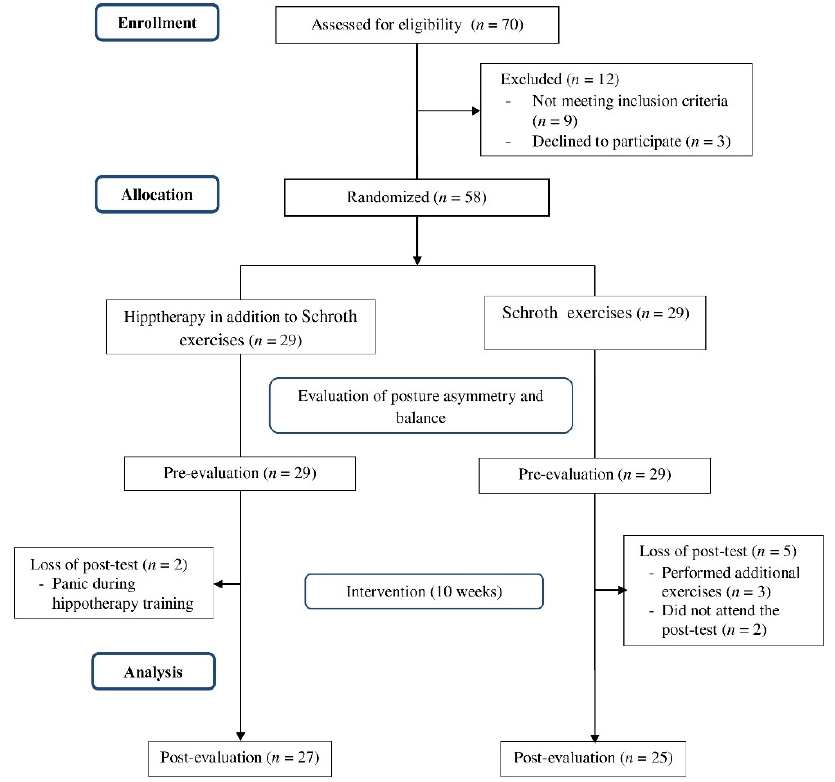
Figure 1. Flowchart of the study processes. Table 1. Participants’ demographic characteristics.